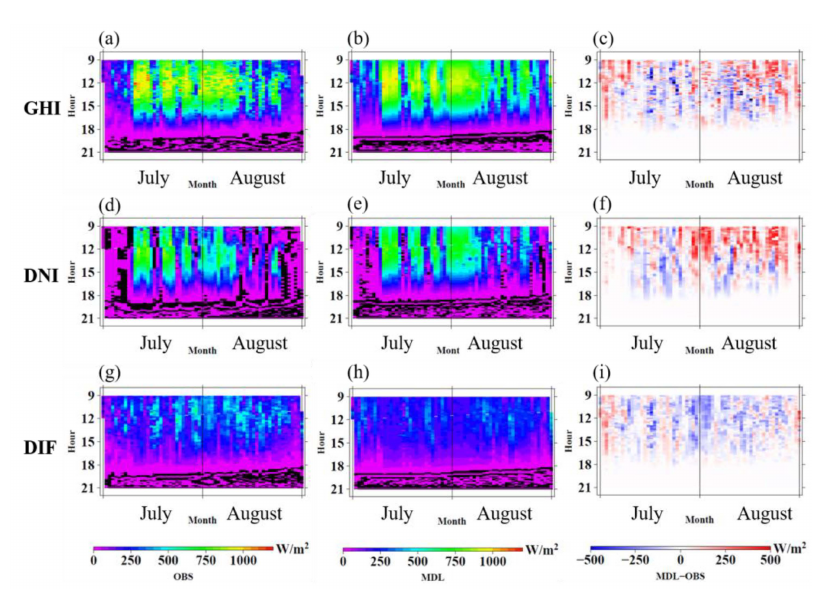
Figure 3. Time cross sections (each day from July to August (horizontal axis; Month)-hours in a day (vertical axis; Hour)) for GHI (top), DNI (middle), and DIF (bottom) for the Exp-Summer of 2015 at Tsukuba station. Left panels show GHI observations, center panels show simulations by dx500m with 00 UTC (09 JST) initialization time and right panels show the di ff erence for dx500m (dx500m–observations). Color scales are shown at the bottom of each